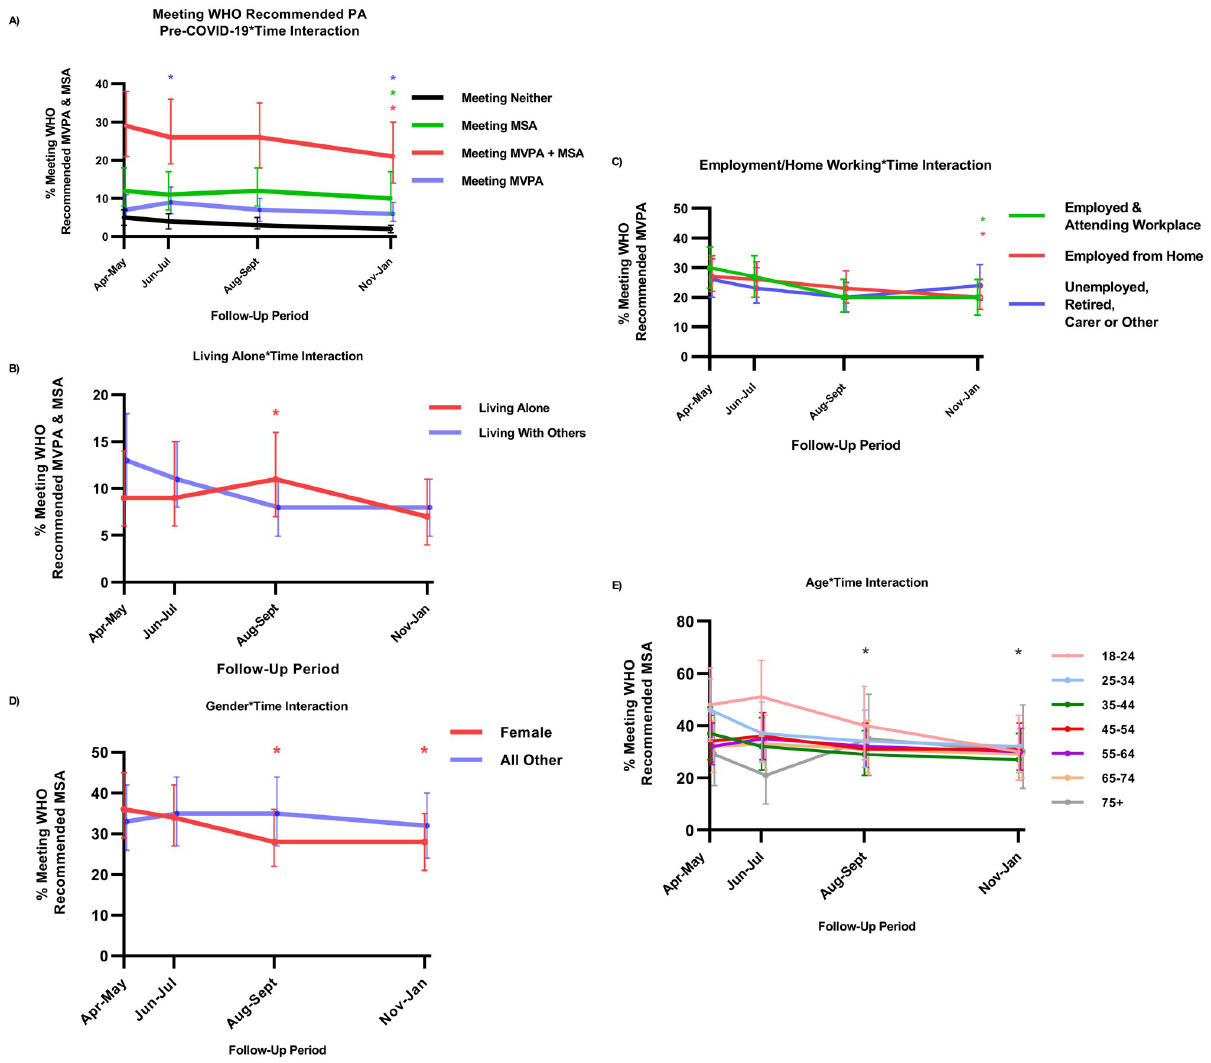
Fig 2. Time-varying associations of factors with meeting total WHO recommended PA levels, MSA & MVPA. A) Meeting any PA recommendation pre-COVID-19 increased odds of meeting WHO recommended levels of PA during the second lockdown. B) Living alone showed higher odds of meeting total WHO recommended levels of PA during the period of eased restriction. C) Working/studying from home or attending a workplace was associated with higher odds of attainment of MVPA during the second lockdown. D) Gender (female) showed lower odds of MSA attainment during the period of eased restriction and second lockdown. E) Age shows a positive association with MSA attainment at these time points � p < 0.05.